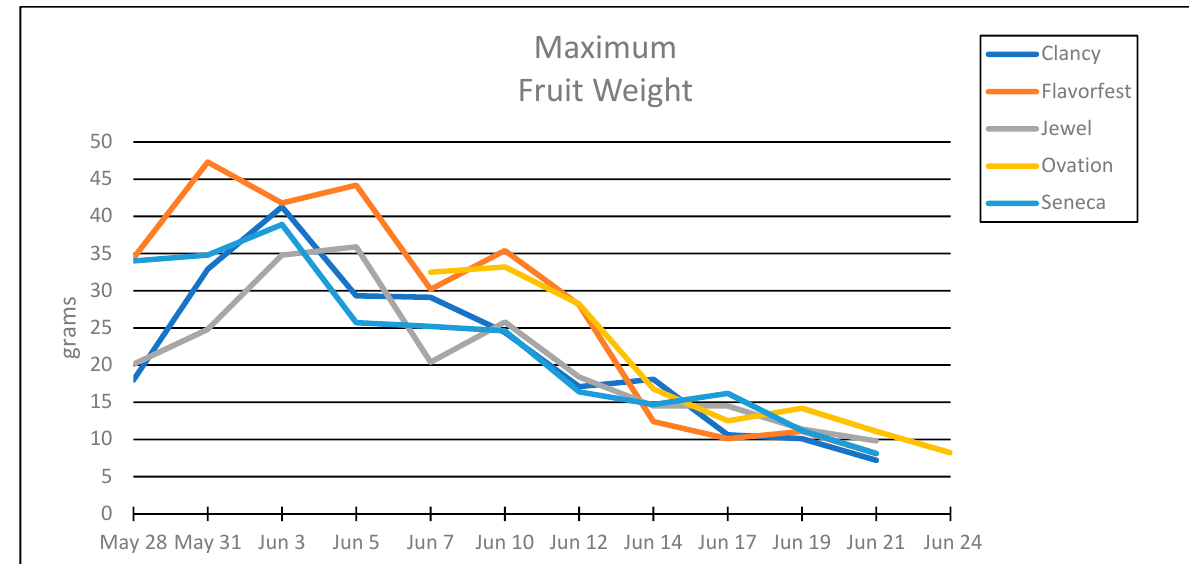
Figure 4. Maximum fruit weight for five short-day strawberry varieties grown in plasticulture in a cold climate region (central NY) in Trial 2 harvested in 2014. High temperatures during fruit development and into the harvest season coincides with a precipitous decline in fruit size towards the middle of the season.